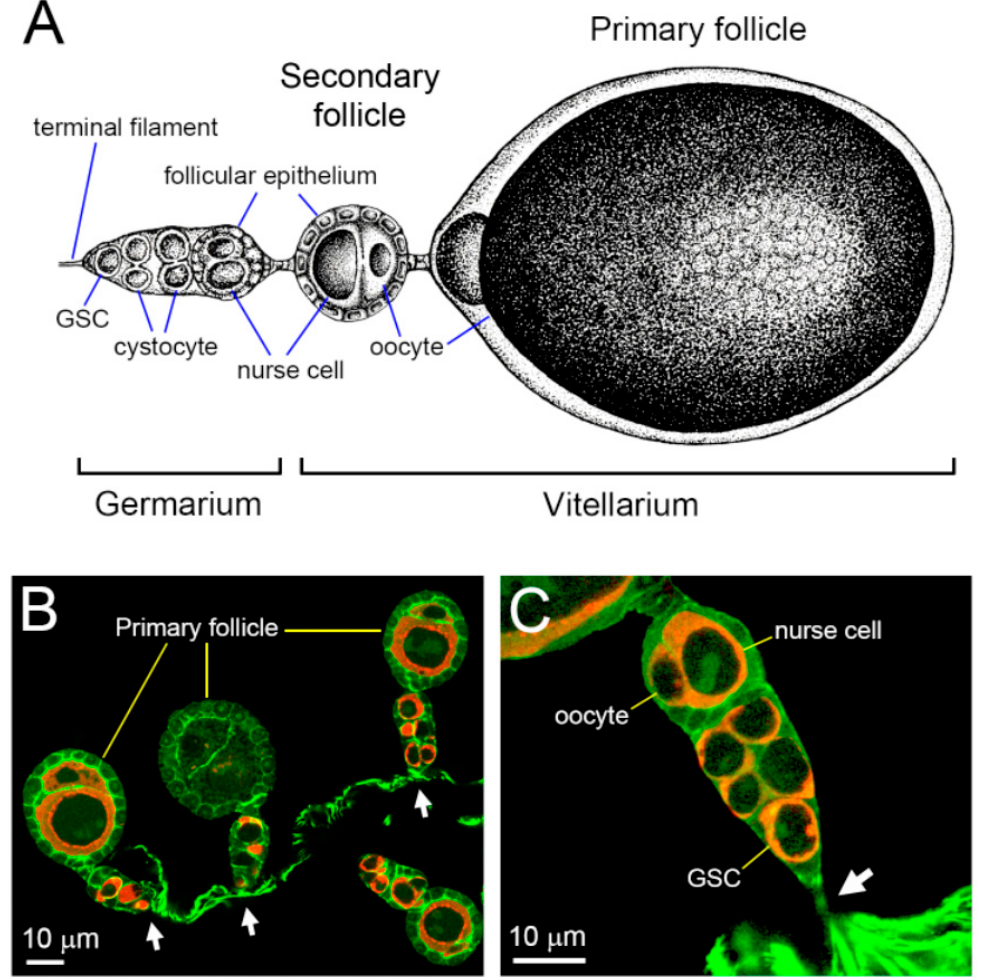
Figure 4. Schematic representation of the ovariole structure and its attachment to the ovarian sheath. ( A ) The ovariole of F. taiwana is composed of two regions: the germarium and vitellarium. In the germarium, it consists of a germline stem cell (GSC), germline cysts consisting two cystocytes, and a nascent follicle in which the oocyte and the nurse cell are enwrapped by a single-layer of follicular epithelium. The vitellarium contains at most two follicles: the primary follicle and secondary follicle. The secondary follicle emerges only when the primary follicle approaching its maturation. In the schematic representation, anterior is to the left. Terminal filament that anchors the ovariole to the ovarian sheath is indicated. ( B ) Ovarioles dissected from the ovary of an unfed female. Only primary follicles can be found. Germaria (arrows) from different ovarioles attached to the ovarian sheath separately. ( C ) Ovariole dissected from the ovary of a female at 15 h PBM. The ovariole is attached to the ovarian sheath via the terminal filament (arrow).